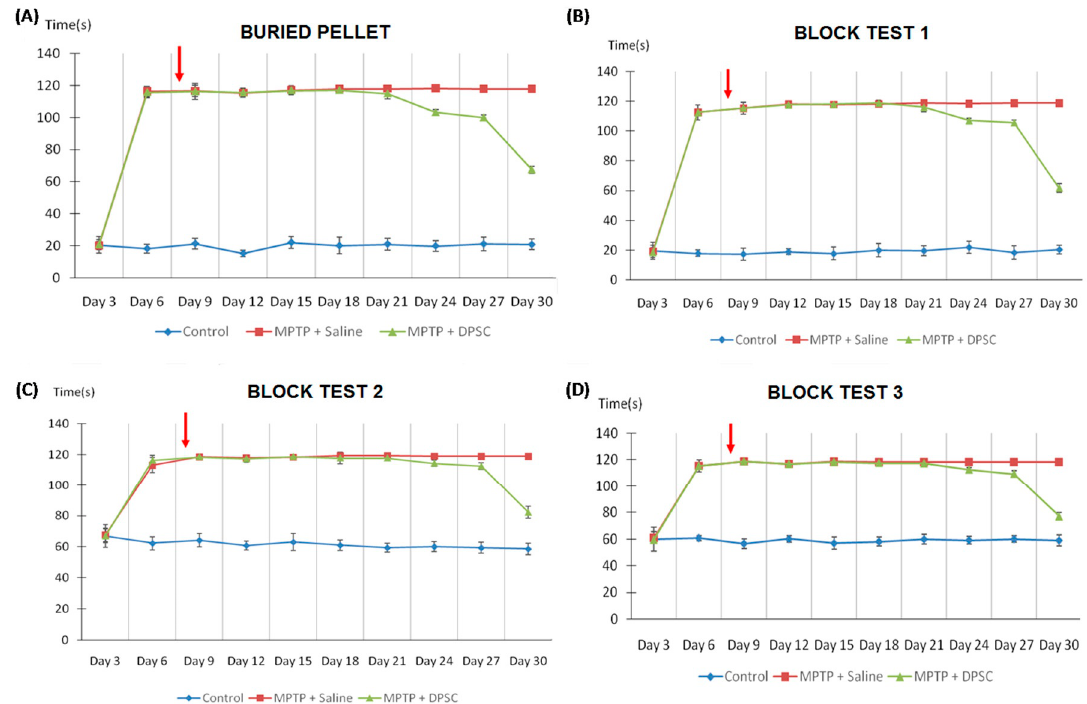
Figure 4. Control, MPTP-induced and DPSC-administered MPTP mice were tested for olfactory function on the buried pellet test and the block test. The time taken to ( A ) discover the hidden pellet and ( B – D ) to discriminate between their own scent and to that of a conspecific were measured. The block test was divided into three levels with increased complexity. MPTP mice took longer to find the hidden pellet and recognize foreign odour when compared with control mice in the buried pellet and block tests respectively. However, olfactory function was significantly improved in MPTP mice across both tests following DPSC delivery (red arrow) at Day 7 ( p < 0.001). Values are expressed as mean ± SD.